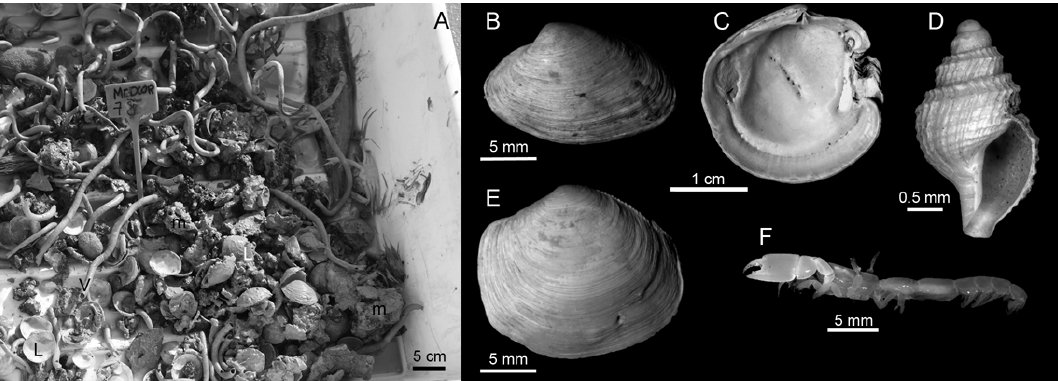
Fig. 7. Chemosymbiotic metazoans recovered from the GBPF: (A) haul whole catch of station MEDCOR 78 (pockmark #1) showing chemosymbiotic bivalves, tubeworms, and carbonate concretions mixed with non-seep fauna and anthropogenic litter; (B) Isorropodon per- plexum from st. MEDCOR71, (C) Lucinoma kazani , theratological shell from st. MEDCOR78, (D) Taranis moerchii from st. MEDCOR69, (E) Myrtea amorpha from st. MEDCOR78, (F) Calliax sp. from st.